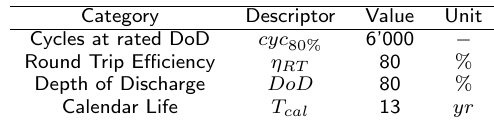
Table 1 Considered BESS parameters from [4]